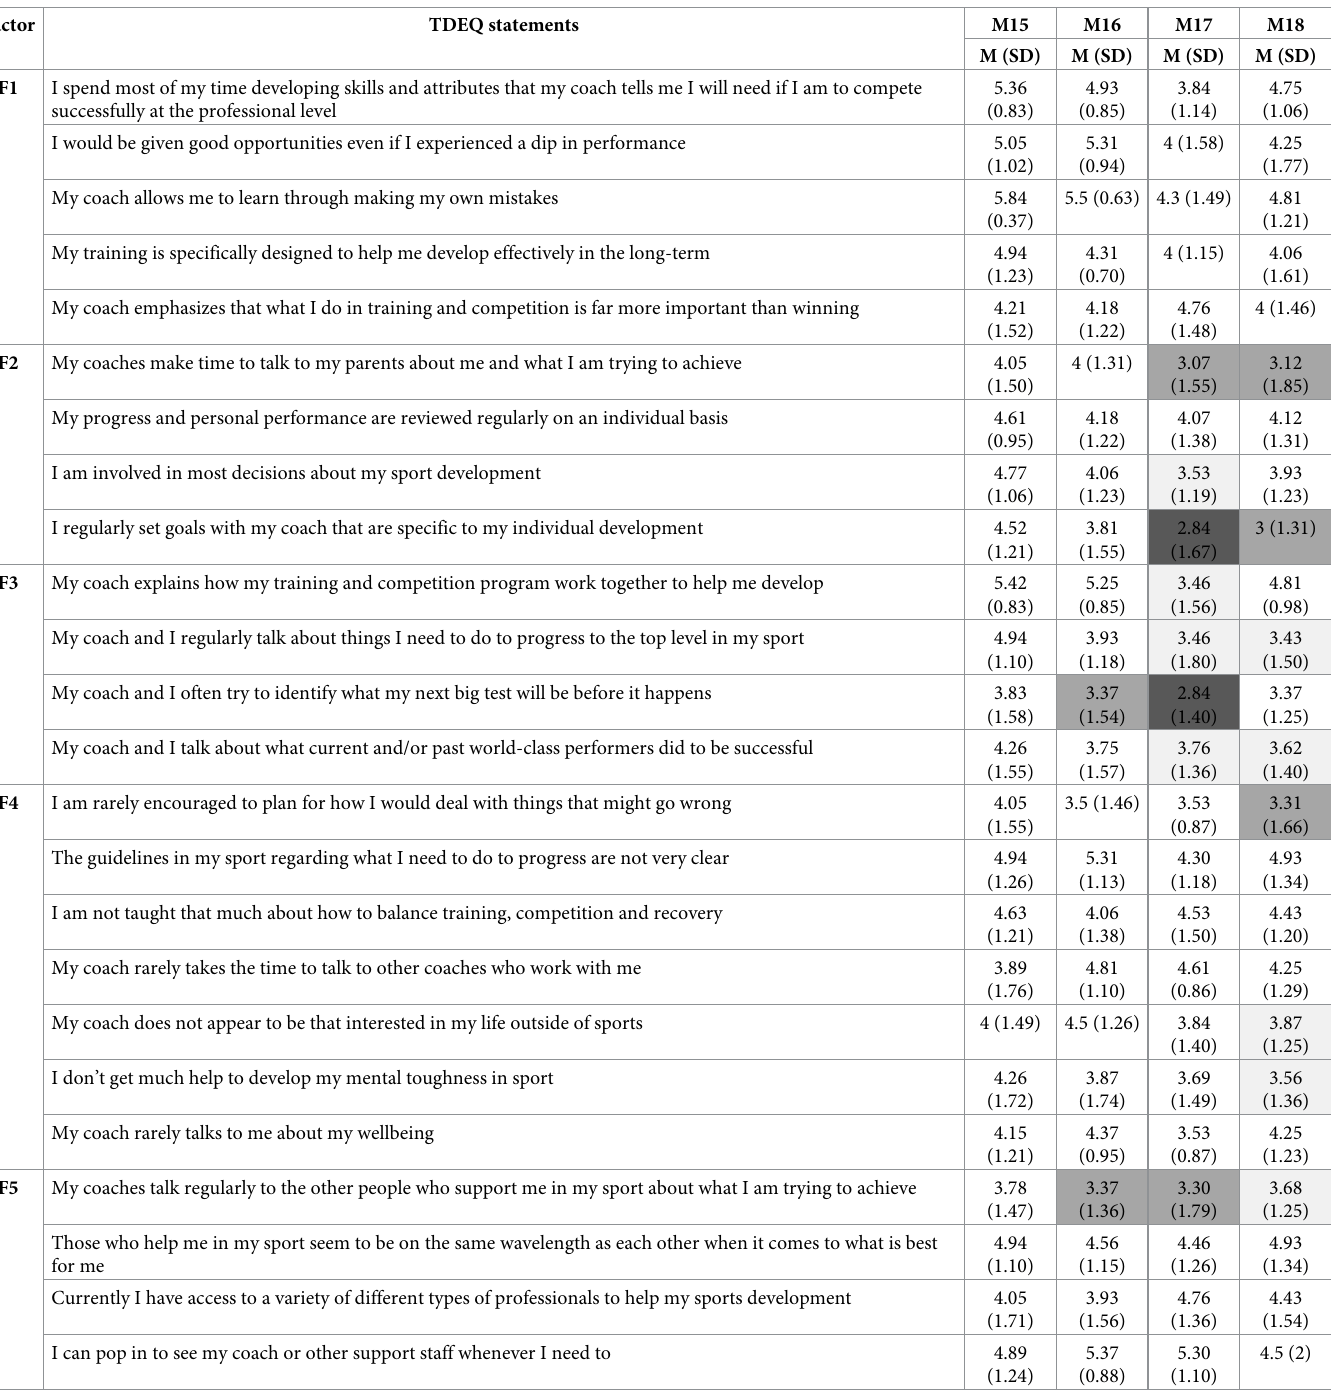
Table 5. TDEQ-FV item analysis for each age-group.